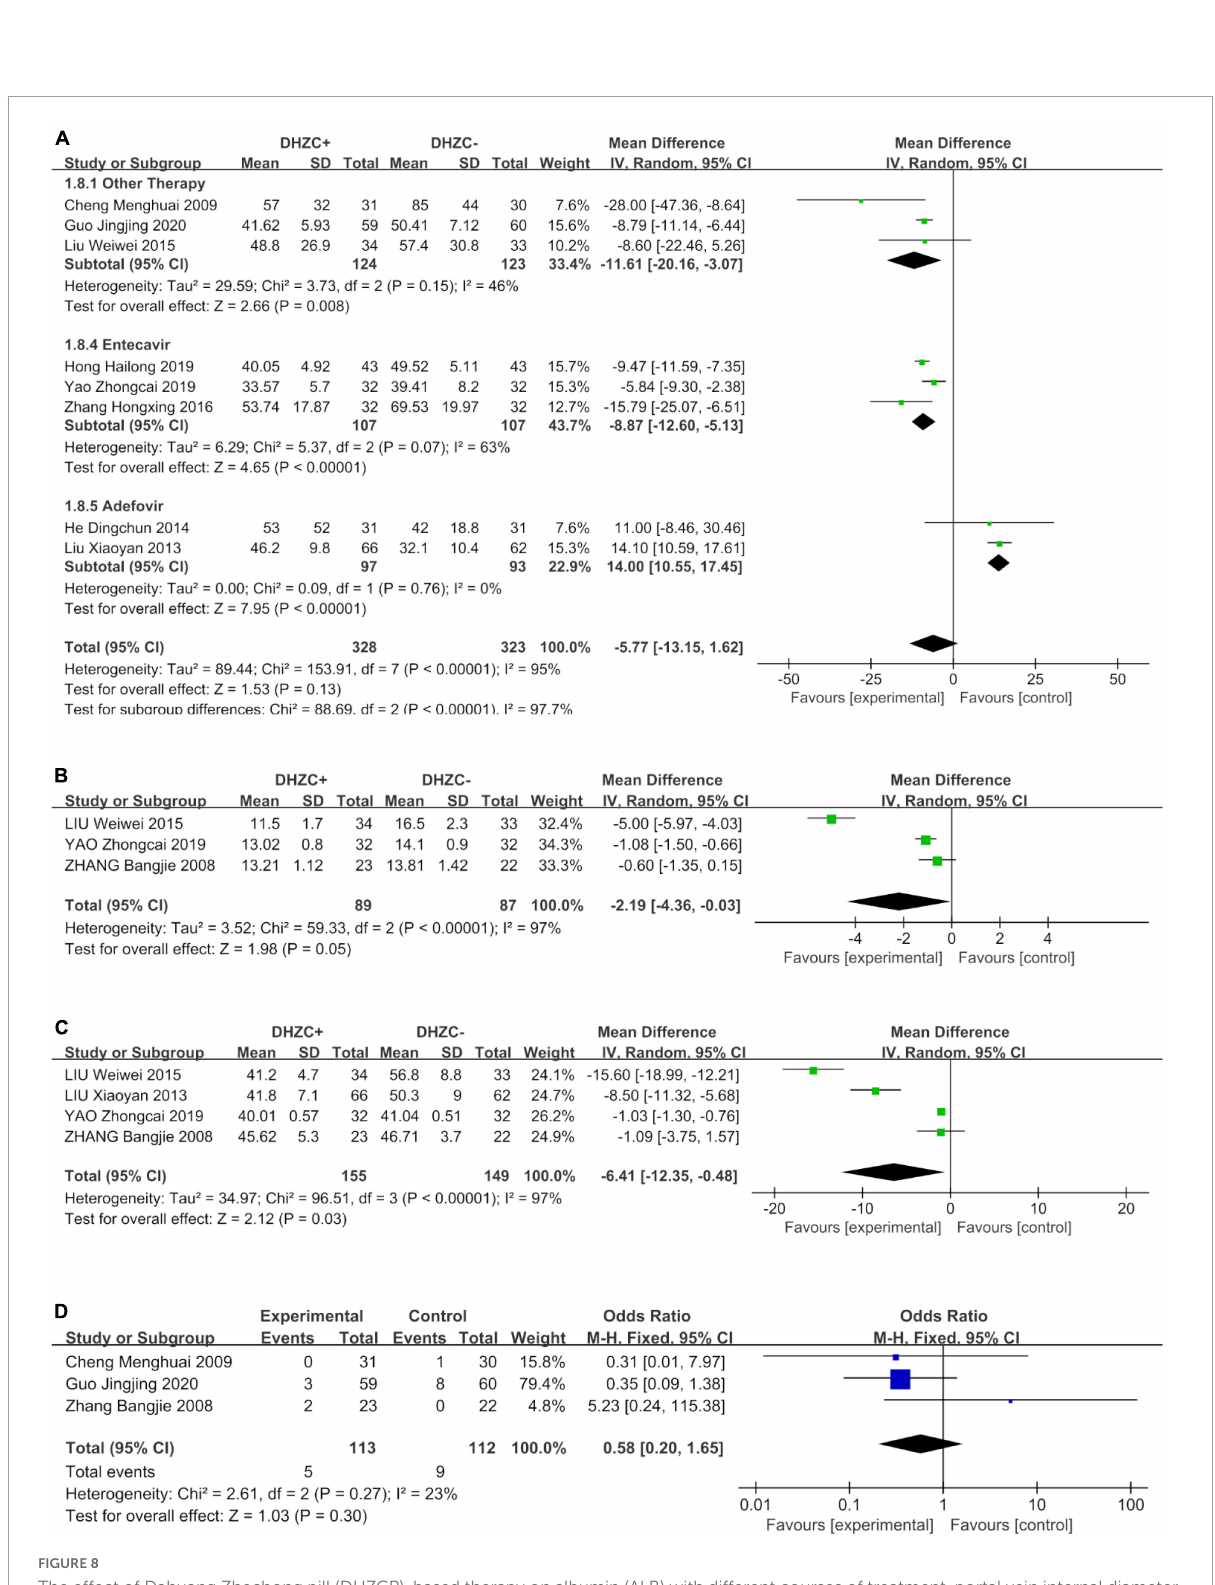
FIGURE8 The effect of Dahuang Zhechong pill (DHZCP)-based therapy on albumin (ALB) with different courses of treatment, portal vein internal diameter, and splenic thickness. The adverse effects are also exhibited. Random-effects models were applied in panels (A–C) . Fixed-effects model was applied in panel (D) . (A) ALB with different courses of treatment; (B) Portal vein internal diameter; (C) Spleen thickness; and (D) Adverse